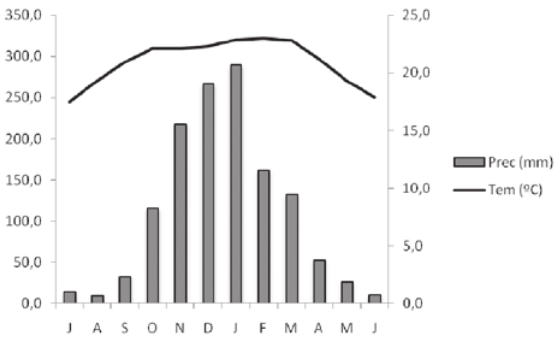
Figure 2 - Climatic diagram of Sete Lagoas, Minas Gerais state, the nearest climatic station to Paraopeba National Reserve (40 km). The columns show the mean monthly precipitation, and the continuous line represents the mean monthly